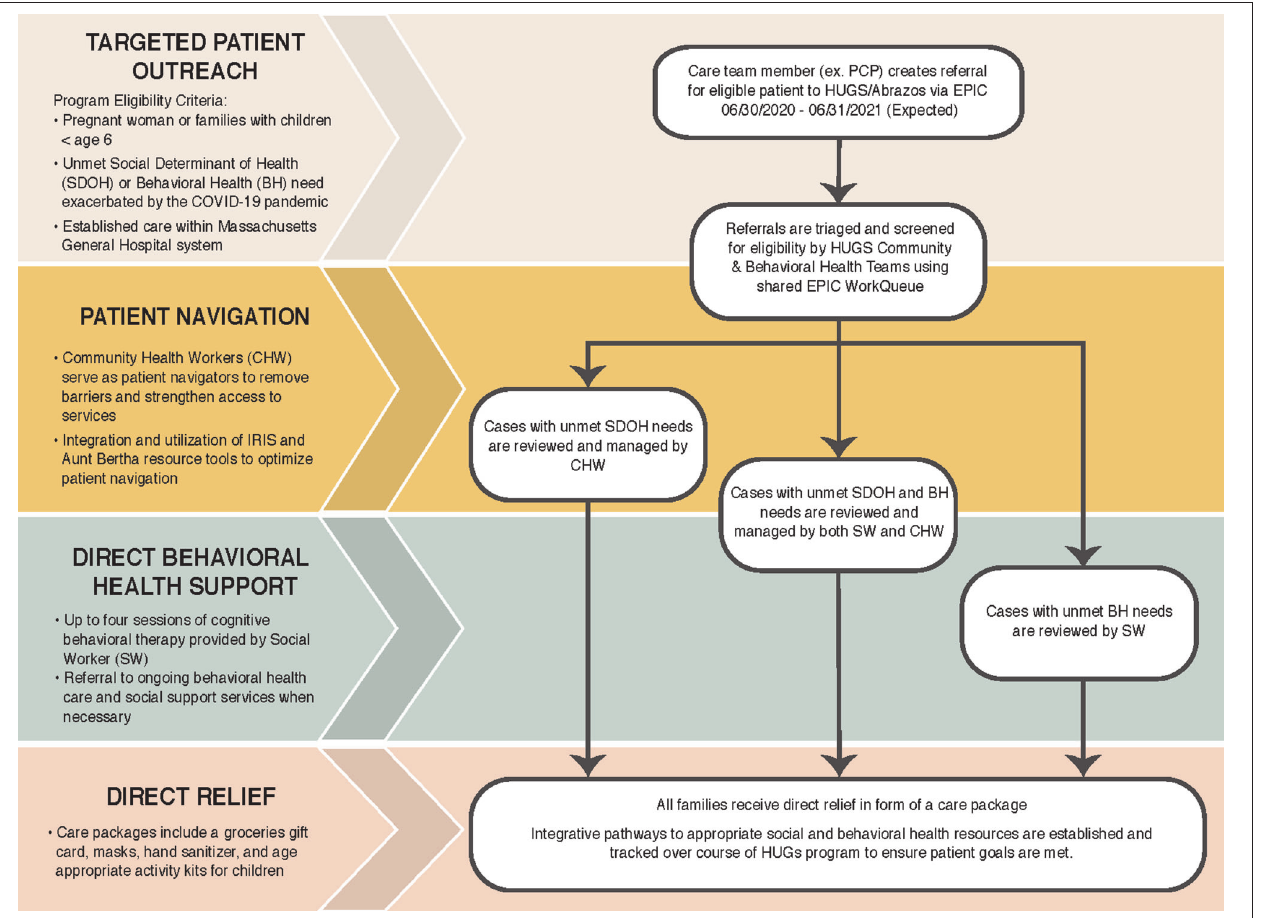
FIGURE 2 | Components of the HUGS/Abrazos COVID Emergency Response Program for Vulnerable Families . Eligible patients and families are referred to the HUGS/Abrazos program by their primary care provider from a participating department-family medicine, pediatrics, OB/Gyn, or internal medicine-at the MGH Community Health Centers serving the towns of Chelsea, Revere, Everett, and Charlestown as well as the MGH Main Campus. CHW, Community Health Worker; BH, Behavioral Health; SW, Social